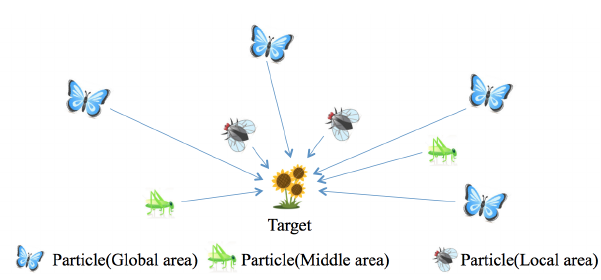
Figure 2. Concept of the proposed PSO with